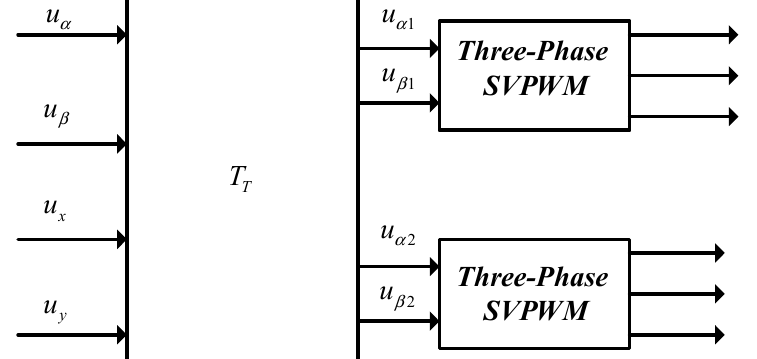
Figure 8. Pulse width modulation (PWM) techniques for four-dimensional current control of ASP_PMSM.